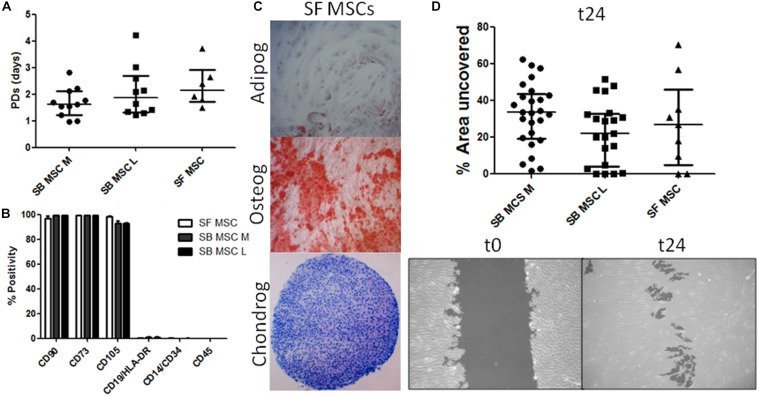
Phenotypical and functional analyses of multipotent stromal cells (MSCs). (A) Comparison of growth rates of medial and lateral subchondral bone (SB) MSCs (SB MSC M and SB MSC L, respectively) and synovial fluid (SF) MSCs measured as population doubling (PD) times (in days). Dots represent individual donors; error bars represent interquartile range (IQR). (B) Phenotypic profile of culture-expanded SF and medial and lateral SB MSCs indicating no differences in the expression of standard MSC markers. Horizontal bars show means and error bars represent standard error (n = 3 donors). (C) Example images of SF MSC adipogenesis assay (Adipog) stained with Oil Red O after 14 days of adipogenic induction (top panel, original magnification ×100), osteogenesis (Osteog) showing positive alizarin red staining on day 14 post osteogenic induction (medium panel, original magnification ×100), and toluidine blue staining for glycosaminoglycan (GAG) deposition (purple) of chondrogenic (Chondrog) pellet cultures on day 21 post induction (bottom panel, original magnification ×40). (D) Analysis of SF MSC motility showing no significant differences between MSCs. Top panel: graph representing the median percentage of wound uncovered by migrating cells after 24 h (relative to the corresponding 0-h area); data represent individual measurements from nine SB MSC donors and three SF MSC donors; error bars represent IQR. Bottom panels: example images showing uncovered area measured at time 0 and at 24 h (t24).